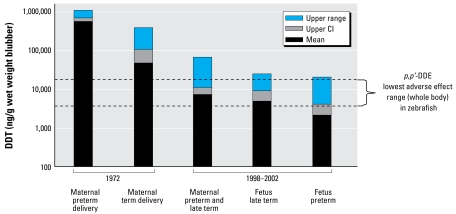
Concentration (ng/g wet weight) of total DDT found in maternal and fetal California sea lion blubber. Data from 1972 is modified from Gilmartin et al. (1976), and data from 1998–2002 is from Greig et al. (2007). The right side of the chart shows the relationship to the whole-body effect levels of p,pDDE (ng/g)-that enhance PTZ-induced seizures in zebrafish.